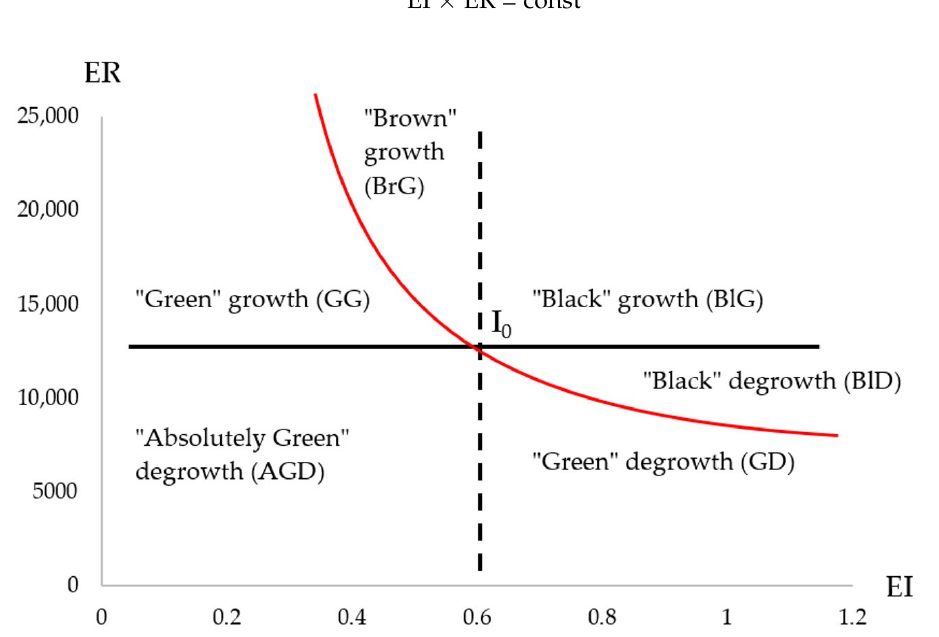
Figure 1. Zones of ecological and economic development of mining in accordance with the modified model of P. Viktor.